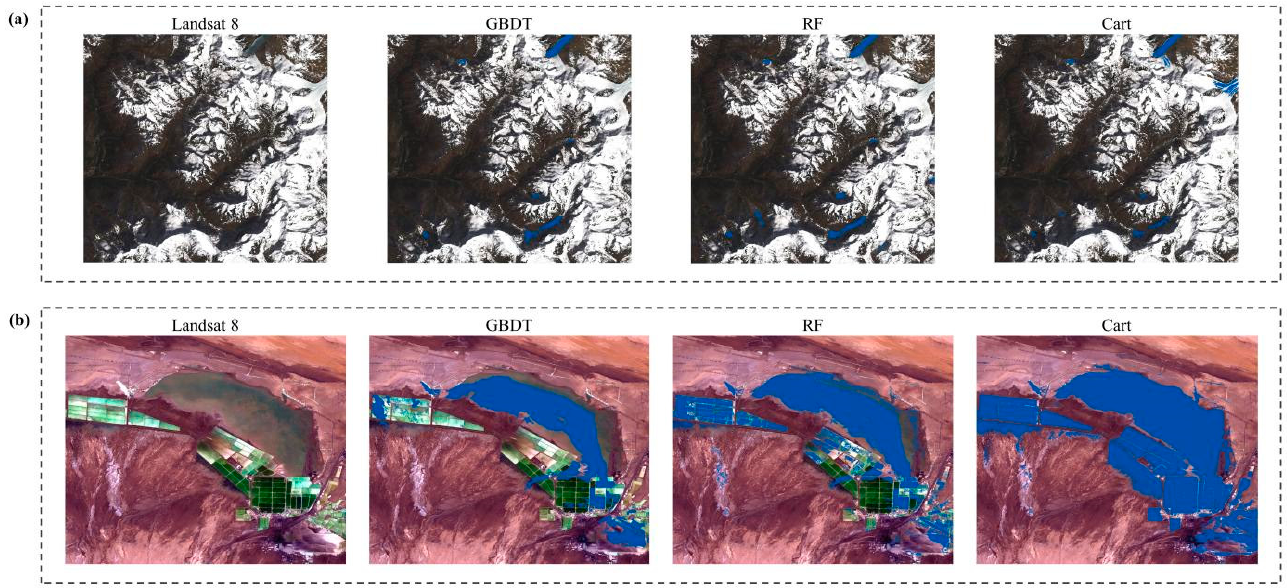
Figure 8. The detailed extraction results of the three classification methods in the difficult areas of lake extraction on the Tibetan Plateau. Among them, ( a ) is the extraction result under the influence of mountain shadow and ice and snow cover, and ( b ) is the extraction result under the influence of similar features such as alluvial deposits and